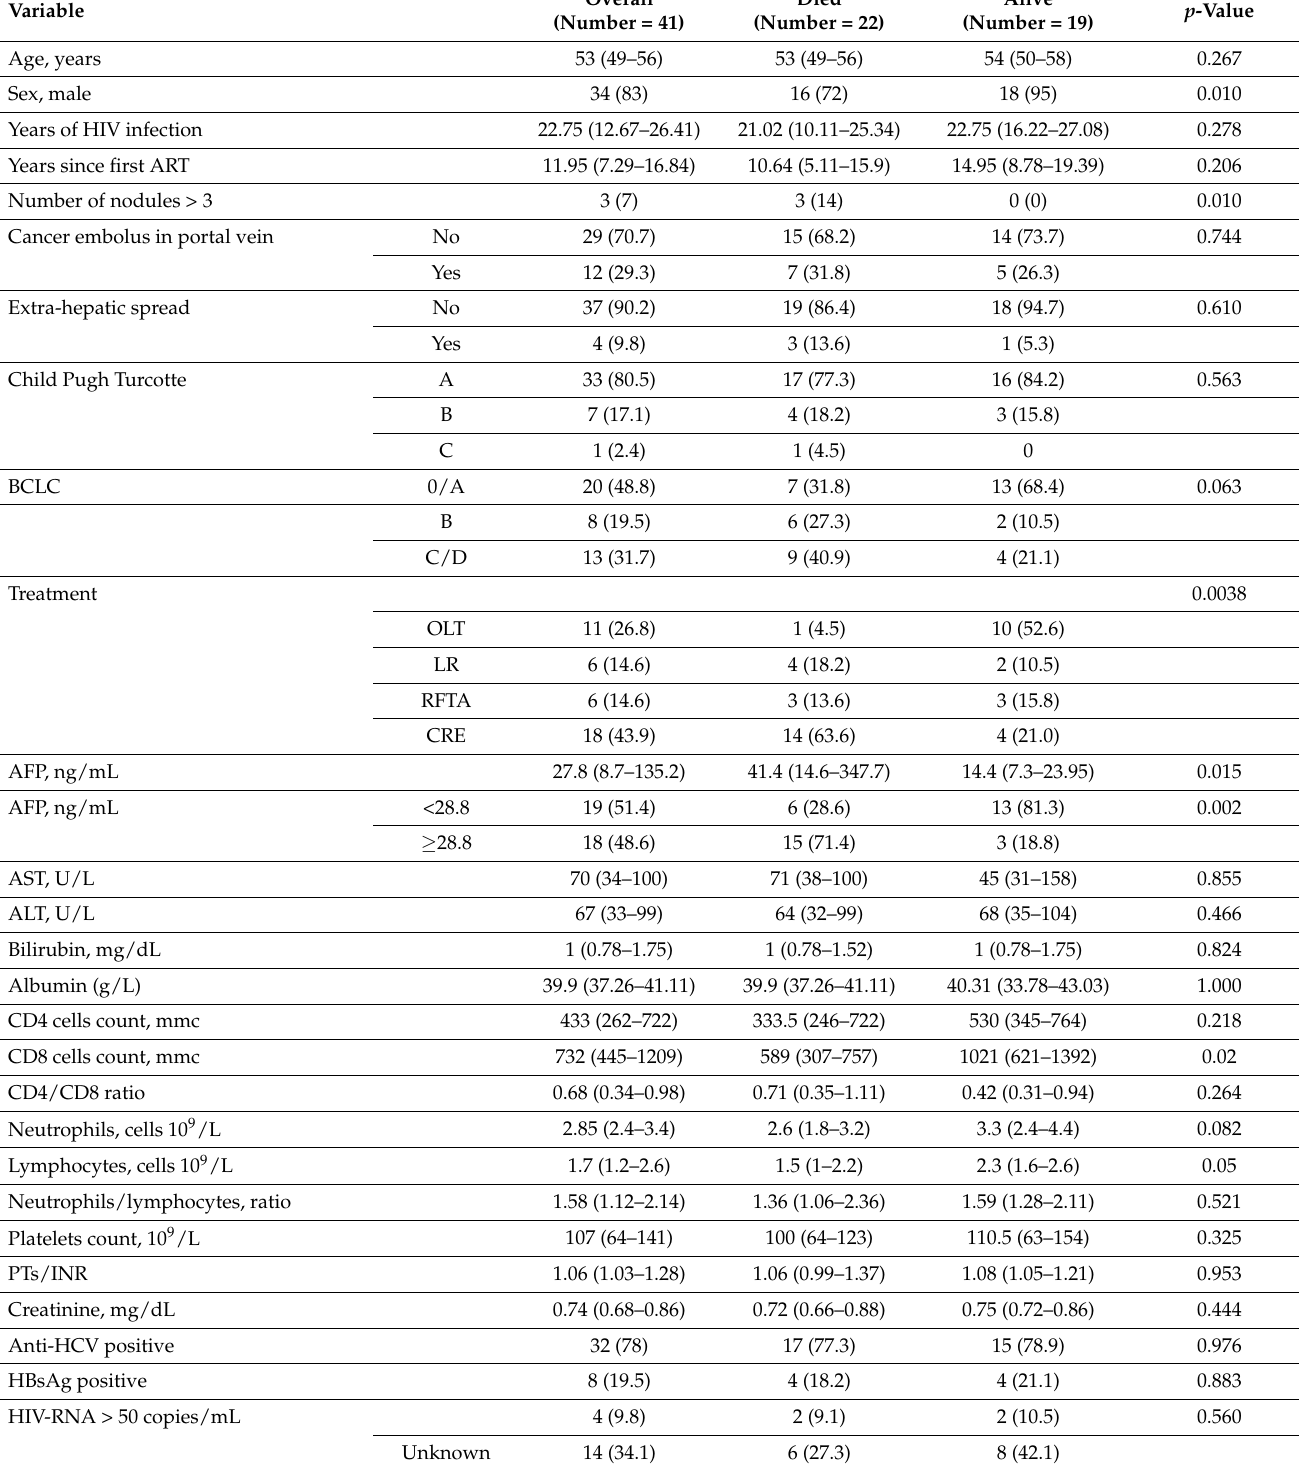
Table 1. Characteristics at HCC diagnosis of PLWH receiving invasive therapy according to the primary study outcome (died or